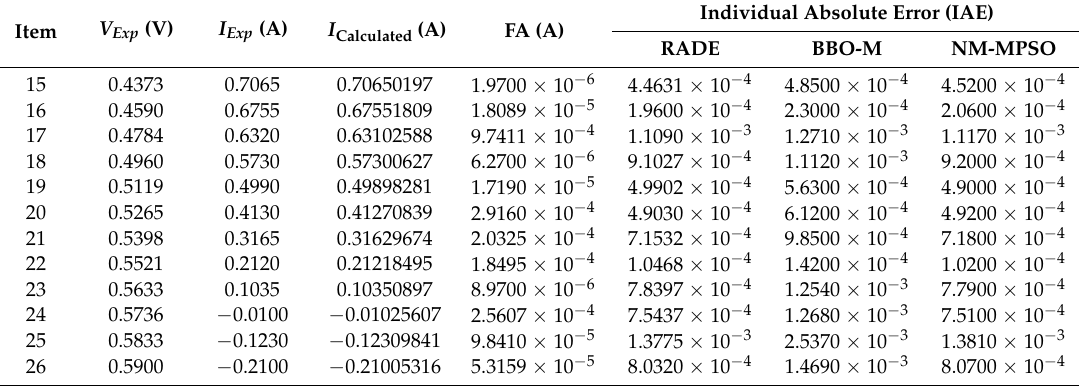
Table 6. Calculated current and compared IAE for double diode (RTC France